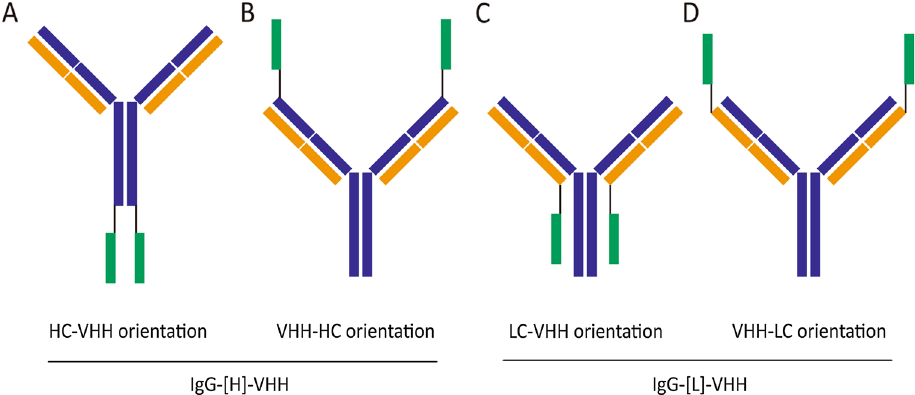
Figure 1. The design of bispecific antibodies. Green is the VHH against TIGIT, deep blue is the heavy chain of anti-PD-L1, brown is the light chain, and black is the linker: (GGGGS)n, n =